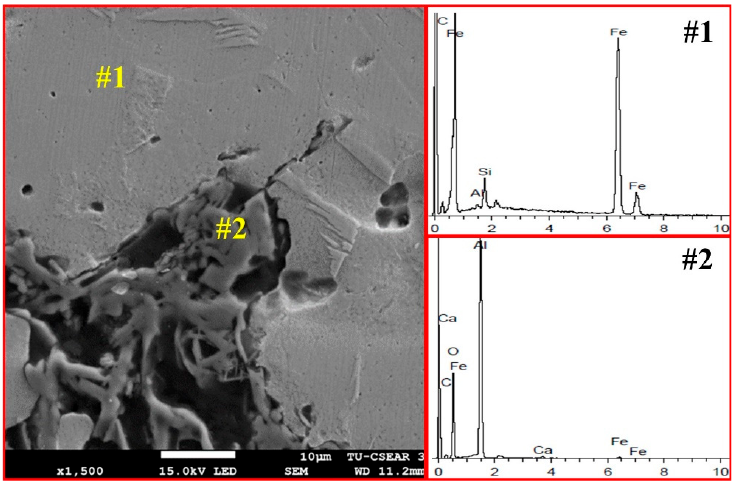
Figure 7. SEM micrograph and EDS spectra of the cross-sectioned pellet (C/O = 1) after heating at 1550 °C for 3 h.